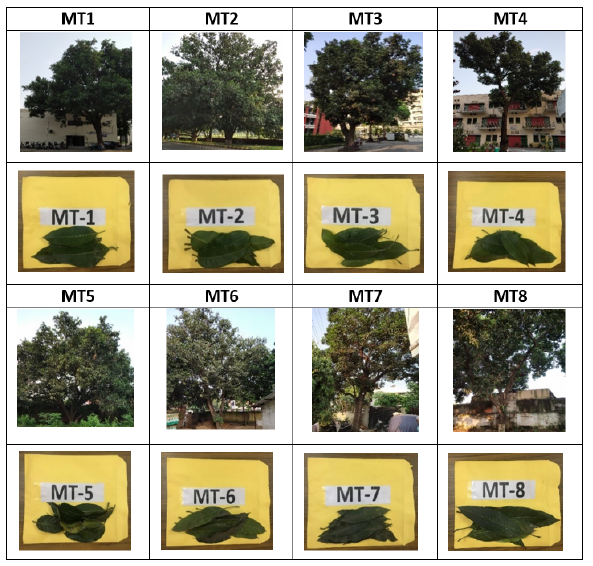
Figure 6.Mango Tree and corresponding leaves samples inside and outside IIT Roorkee campus